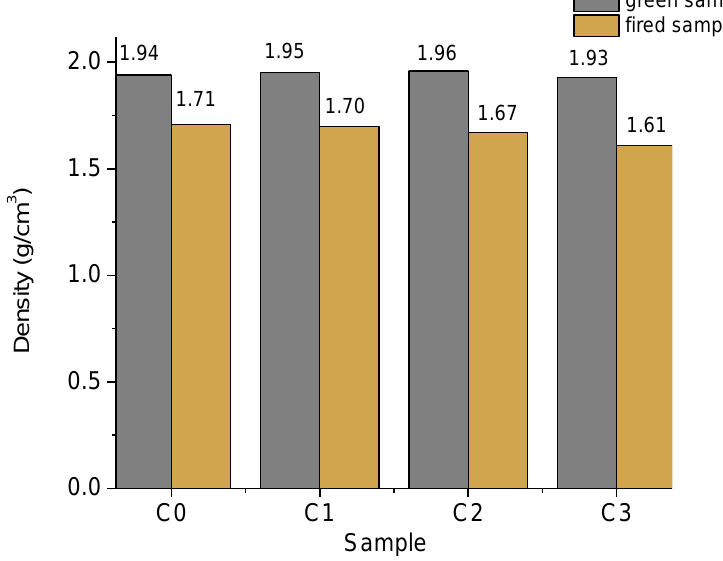
Figure 7. Density of green and fired samples (g/cm 3 ). The samples with limestone as an admixture (C1–C3) were materials with high density (>1 g/cm 3 ), normally being proper for masonry, and are protected against water with cladding materials if the firing temperature is lower than 1000 °C.